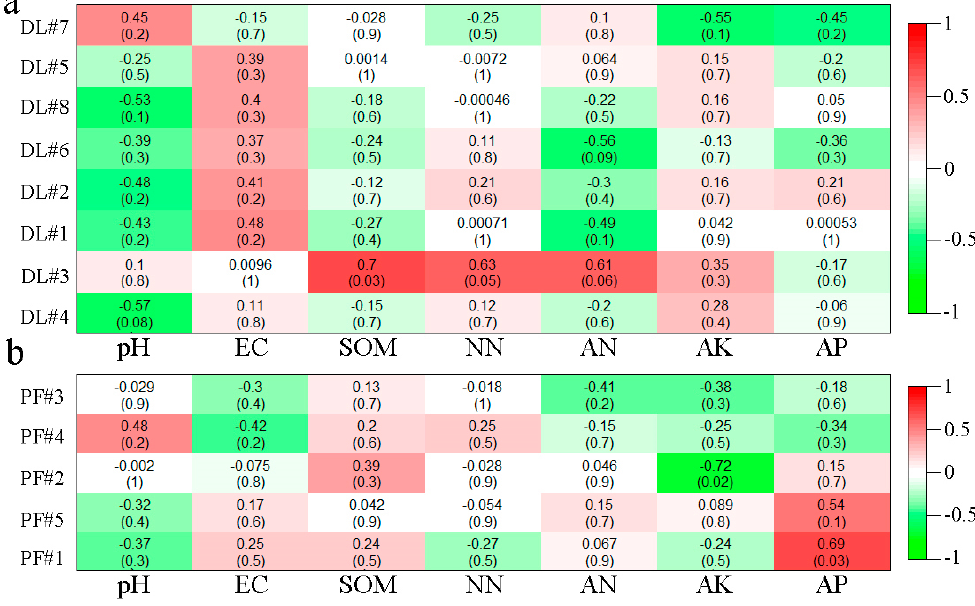
Figure 8. Heatmap analysis of fungal module correlation with environmental factors in DL ( a ) and PF ( b